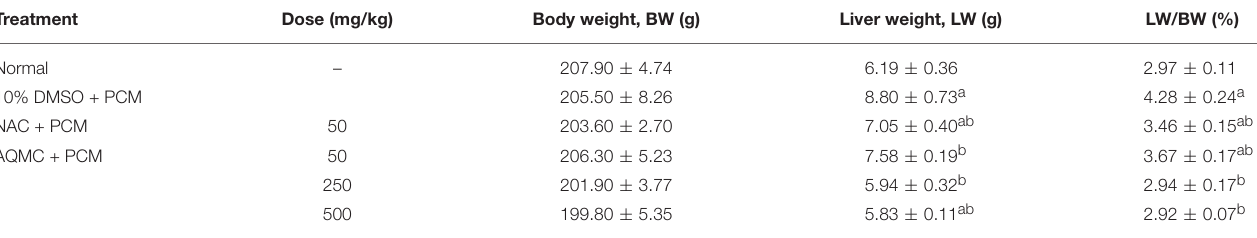
TABLE 5 | Effect of AQMC, at the doses ranging between 50 and 500 mg/kg, on the body and liver weights, and liver/body weight ratio of PCM-intoxicated rats. Treatment Dose (mg/kg) Normal